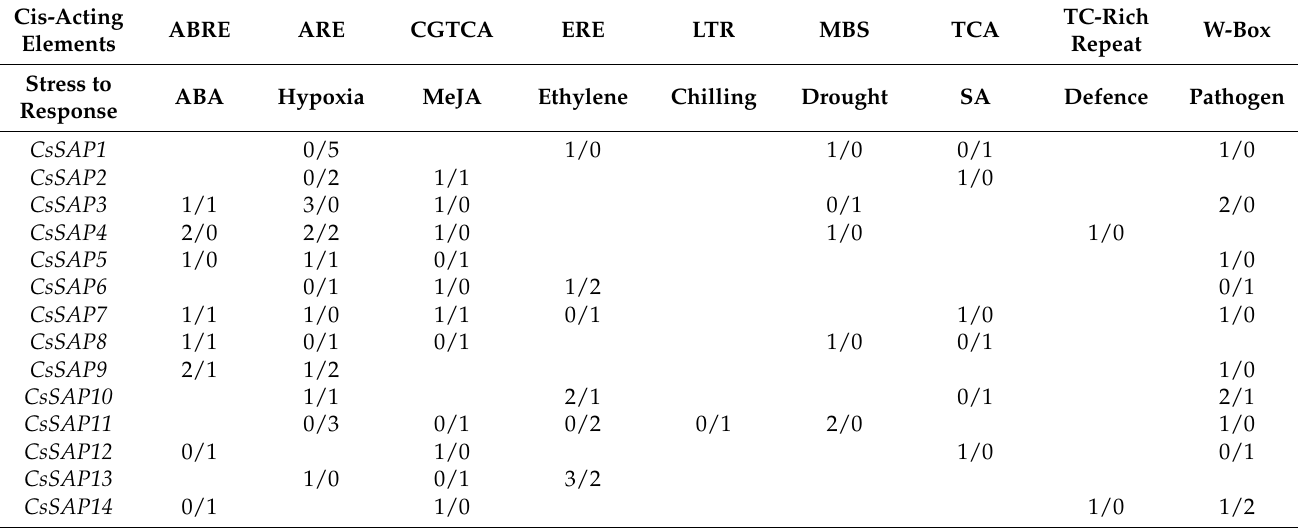
Table 2. The cis-acting elements analysis of CsSAPs